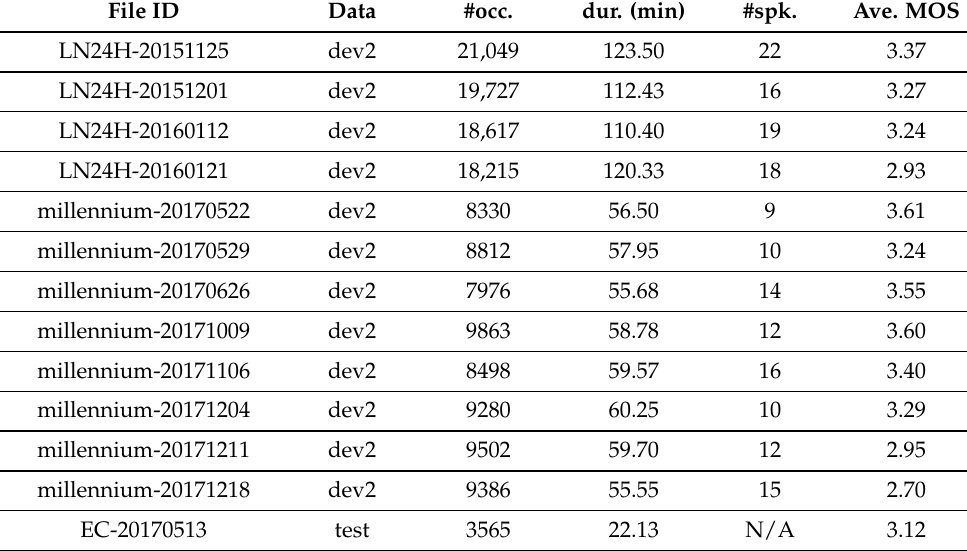
Table 2. Characteristics of the RTVE database: number of word occurrences (#occ.), duration (dur.) in minutes (min), number of speakers (#spk.) and average MOS (Ave. MOS). These characteristics are displayed for training (train), development (dev), and testing (test) datasets. The results for train and dev1 are not reported per file due to the large number of files (about 400 for train and about 60 for